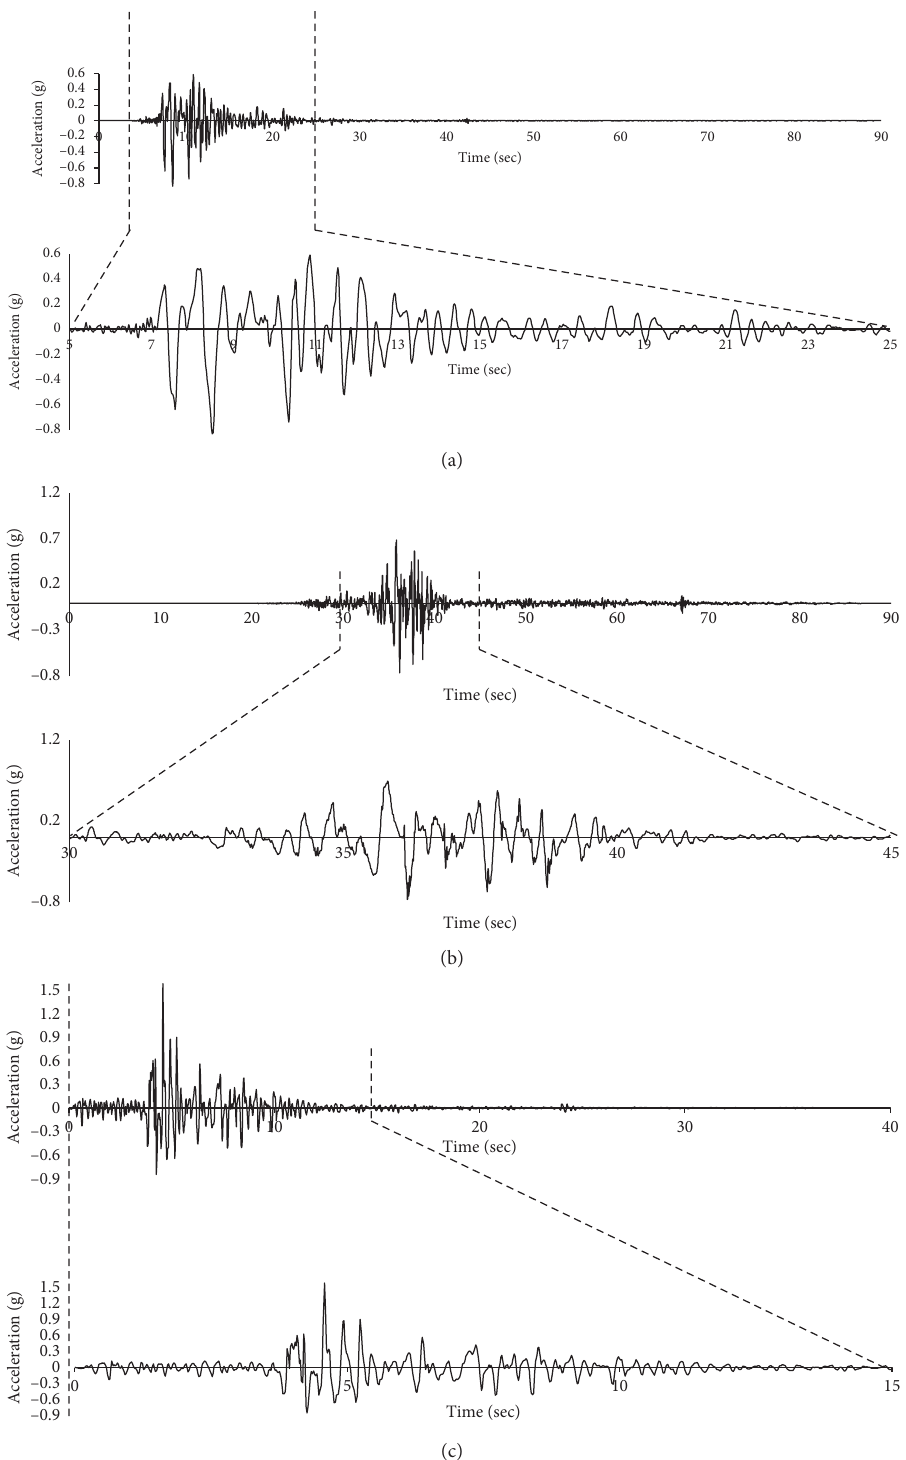
Figure 13: (a) Original and reduced 1995 Kobe earthquake ground motion. (b) Original and reduced 1999 Chi-Chi earthquake ground motion. (c) Original and reduced 1994 Northridge earthquake ground ground. At the 15th second, the left box girder initiated webs of the box girder showed excessive cracks. At 7.25 failure in shear and settled on the ground. At analysis seconds, the web of the right box girder failed mainly in shear. At 8 seconds, the right bay of the box girder hit the